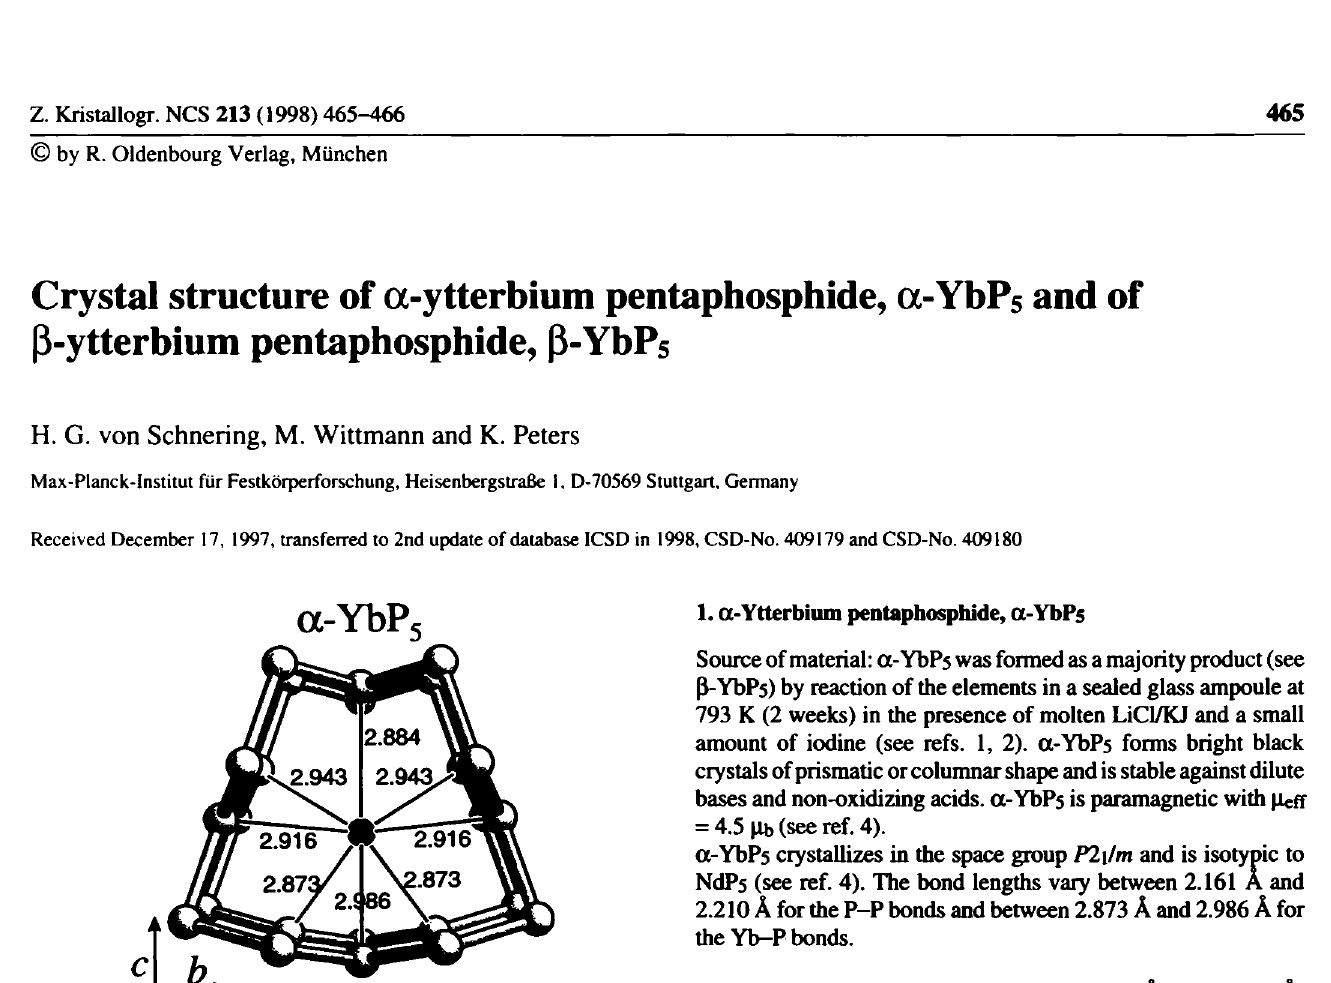
Table 1. Parameters used for the X-ray data coUectioD Crystal: